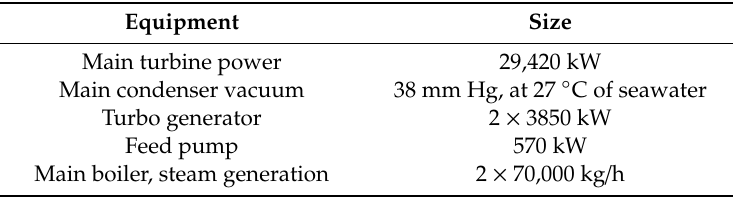
Table 1. Steam propulsion plant main characteristics.